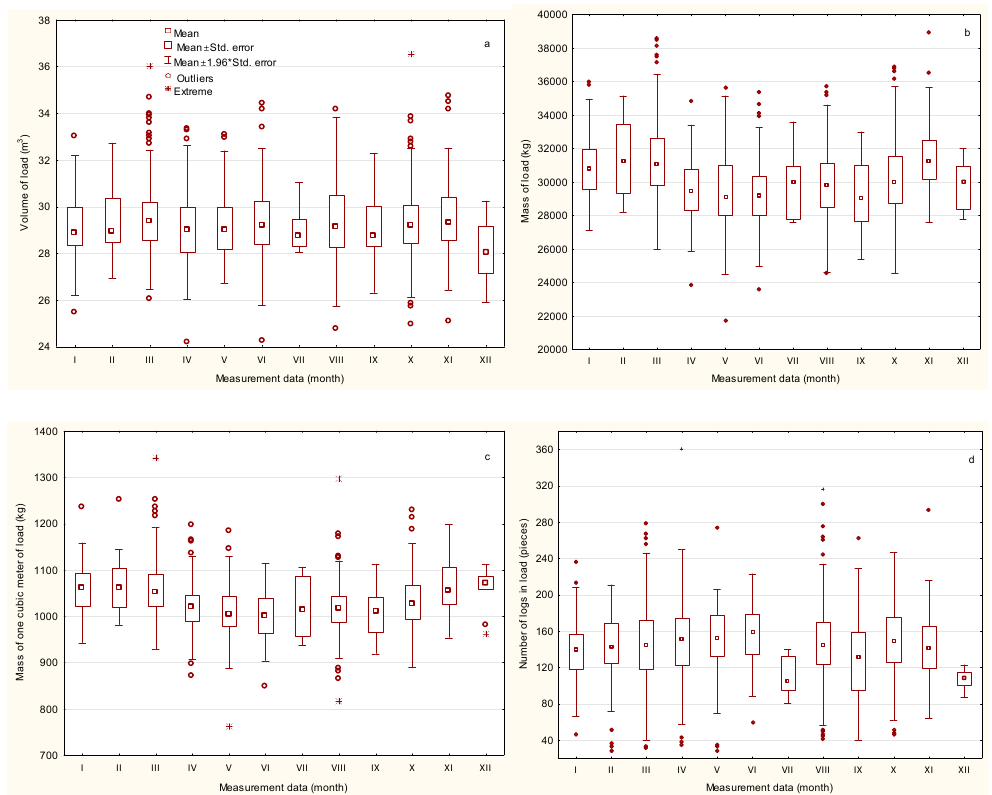
Figure 2. Comparison of average values characterizing timber loads depending on delivery date. ( a ) load volume, ( b ) load mass, ( c ) mass of 1 m 3 , ( d ) number of logs (pieces).